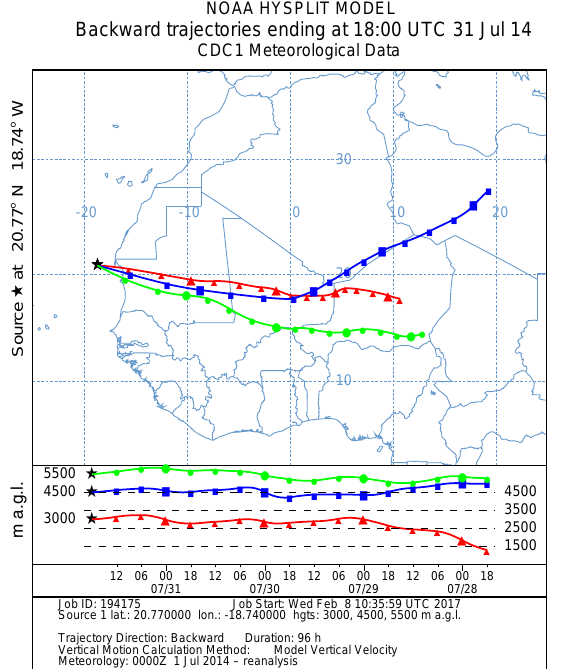
Figure A8. Four-day back trajectories at a height of 3000, 4500 and 5500m on 8 August